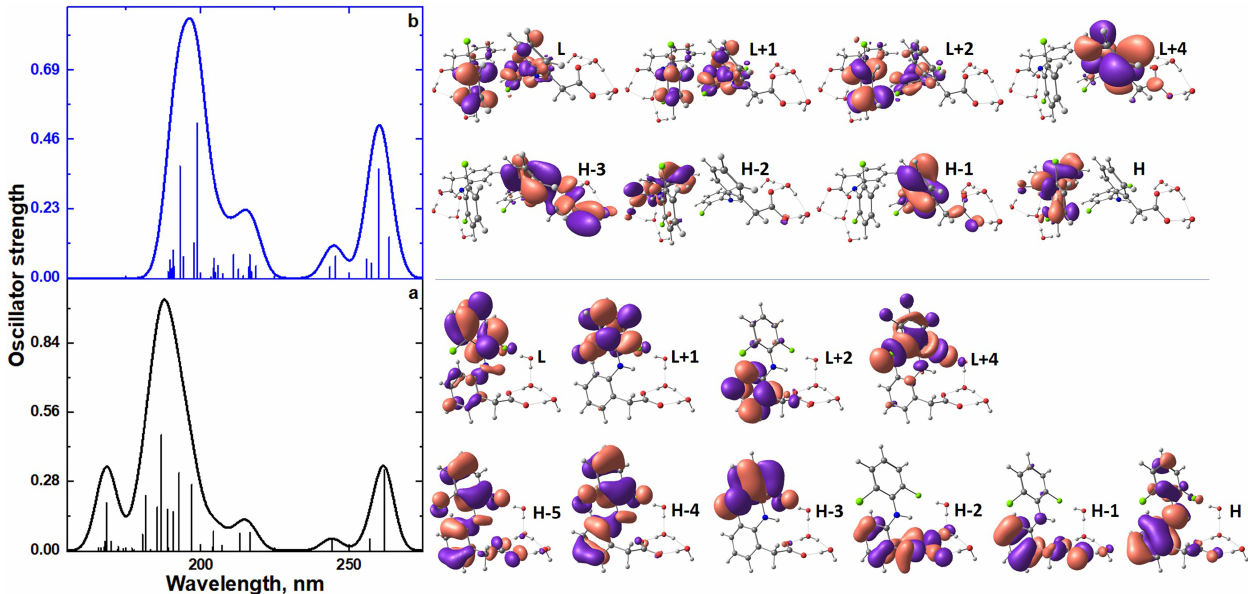
Figure 9. TDDFT spectra of monomer (anion diclofenac · 3H 2 O) ( a ) and its dimer ( b ); the view of frontier molecular orbitals of monomer (anion diclofenac · 3H 2 O) and its